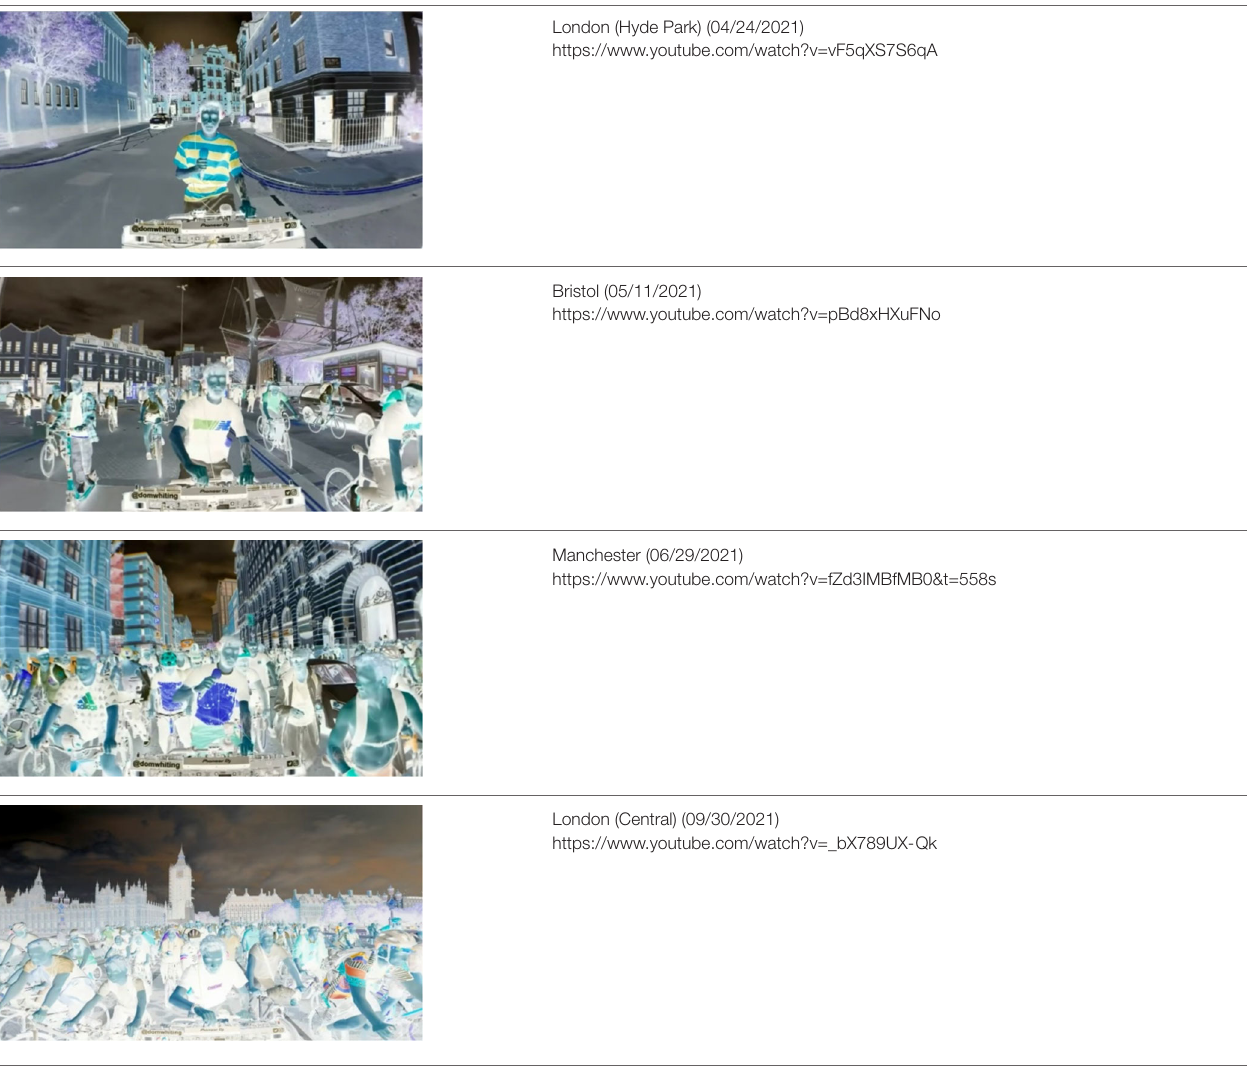
TABLE 3 | The reformation of urban road space